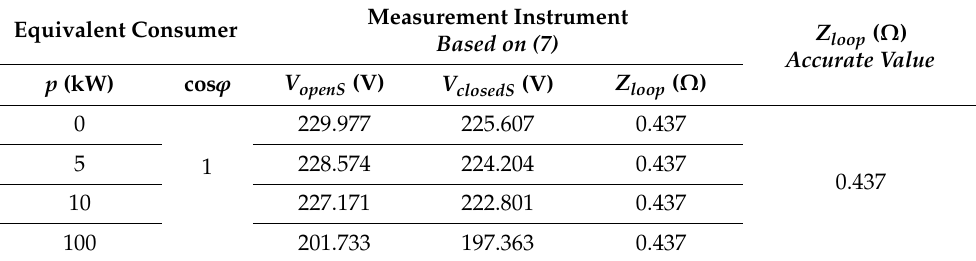
Table 3. Purely resistive network.